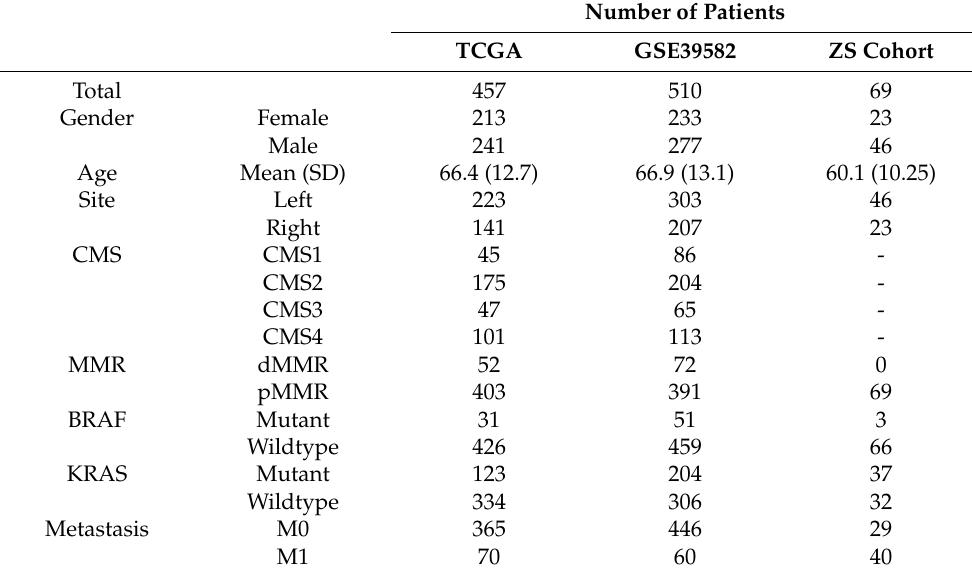
SD, standard deviation; CMS, consensus molecular subtype; MMR, mismatch repair; dMMR, mis- match repair deficiency; pMMR, mismatch repair proficiency.